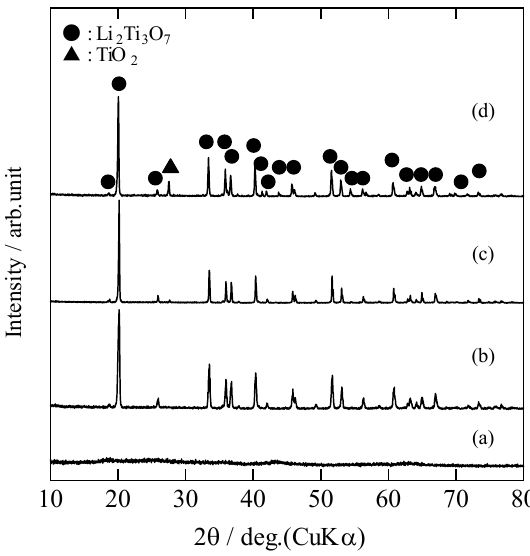
Figure 1. XRD pattern of ( a ) as-prepared powders; and ( b ) ramsdellite-type Li (RLTO) powders calcined at 1100  C under argon/hydrogen; ( c ) air; ( d ) nitrogen.